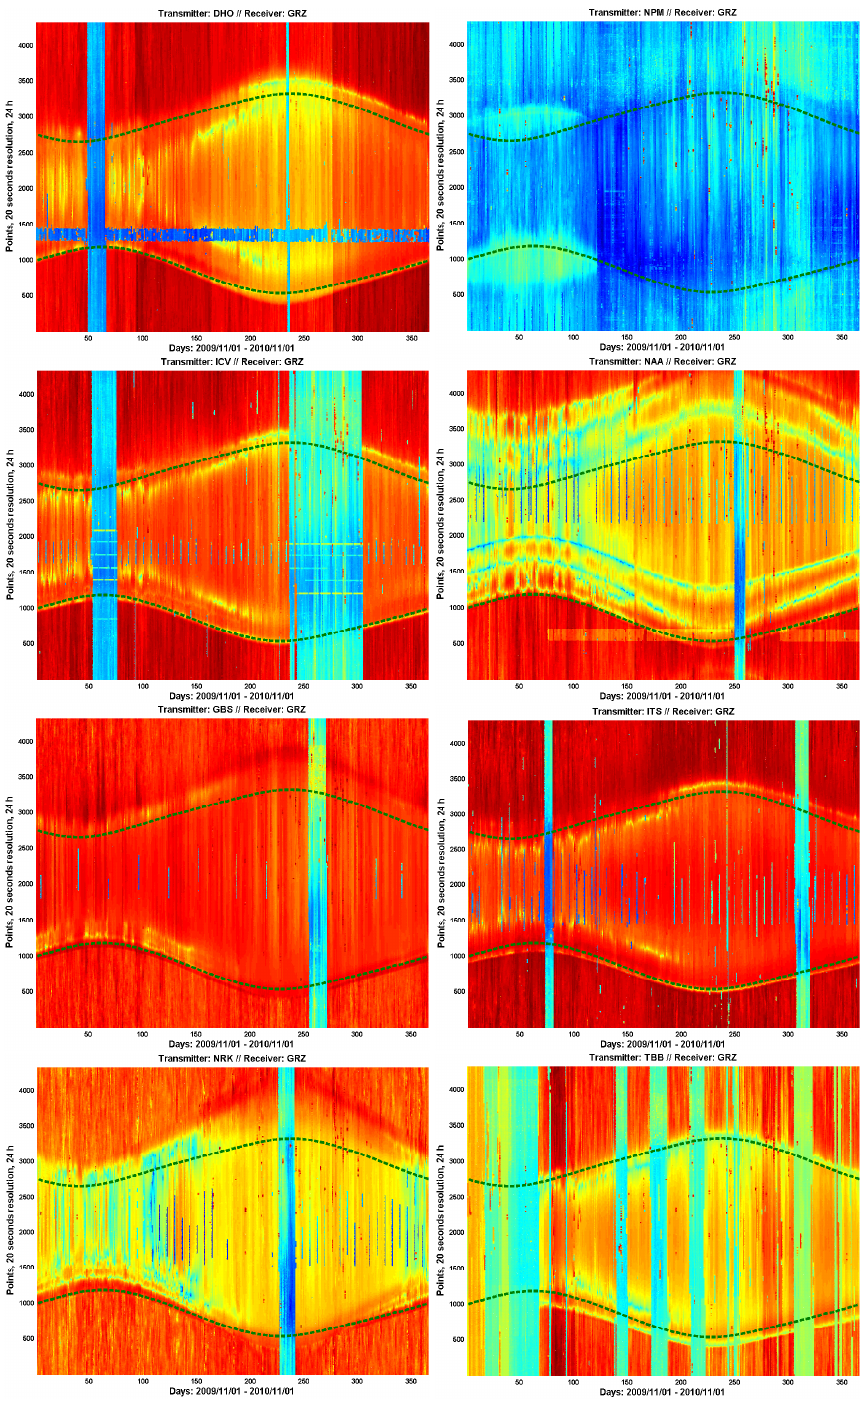
Fig. 6. Colour coded VLF amplitudes – from 2009/11/01 to 2010/11/01 – for the paths from the 8 transmitters of the network listed in Table 2 to GRZ receiving station; upper left is the top view from Fig. 2. From top left to bottom right the paths are { DHO, NPM, ICV, NAA, GBS, ITS, NRK, TBB } -GRZ. Superposed are the official sunrise and sunset times for GRZ (dotted lines); civil-, nautical-, and astronomical times are not